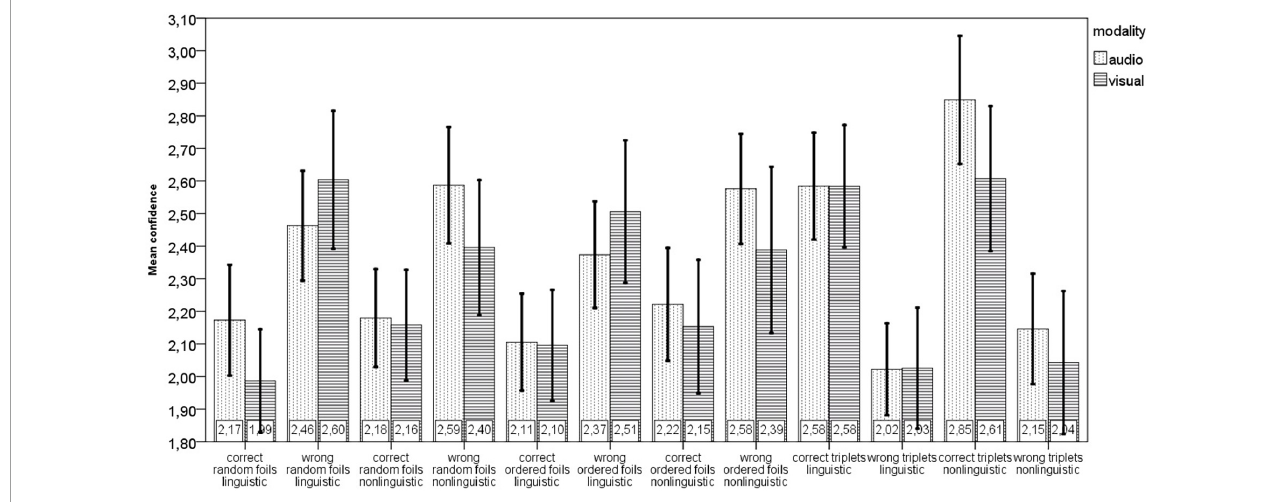
FIGURE2 Confidence ratings assigned to correct and incorrect responses for different token types (random and ordered foils and triplets), stimulus types (linguistic and non-linguistic), and modalities (visual and auditory).